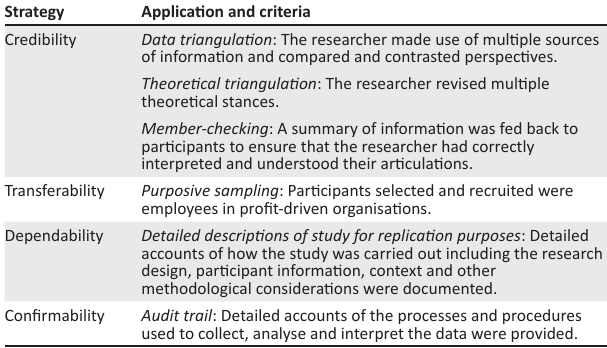
TABLE 2: Strategies employed to ensure trustworthiness of